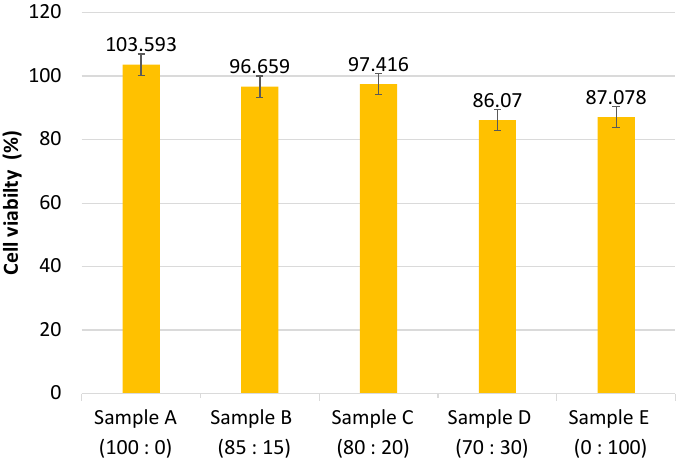
Figure 7. Graph of cell viability percentage of the samples with a composition of PLA:PCL; A (100:0), B (85:15), C (80:20), D (70:30), and E (0:100) in wt%.